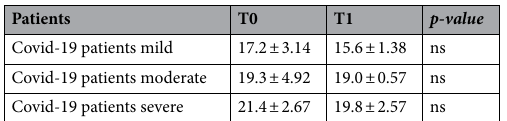
Table 3. Adiponectin serum concentrations (µg/ml) in COVID− 19